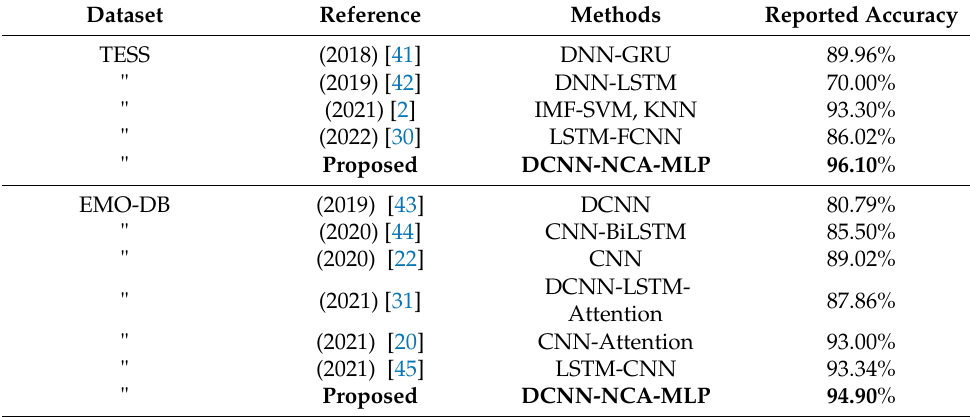
Table 5. Performance